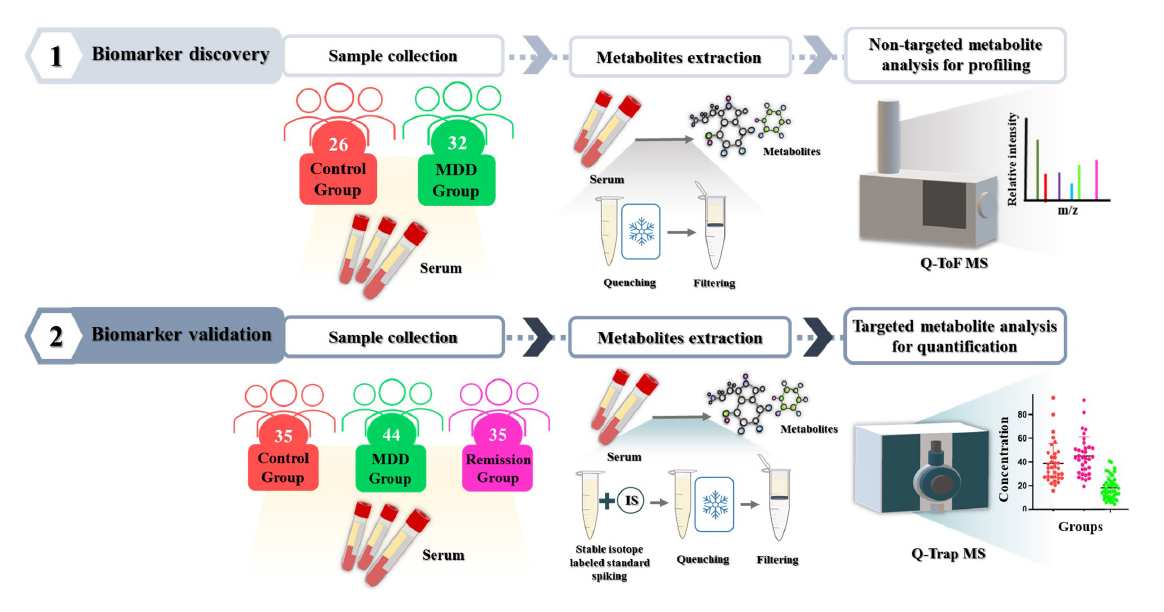
FIGURE1 Experimental workflow. To discover metabolites that differed significantly between the depression patient group and the control group, serum metabolites were profiled using non-targeted metabolomic technique with Q-ToF mass spectrometry. Then, their effectiveness as biomarkers was validated in independent validation set using targeted metabolomic technique with Q-Trap mass